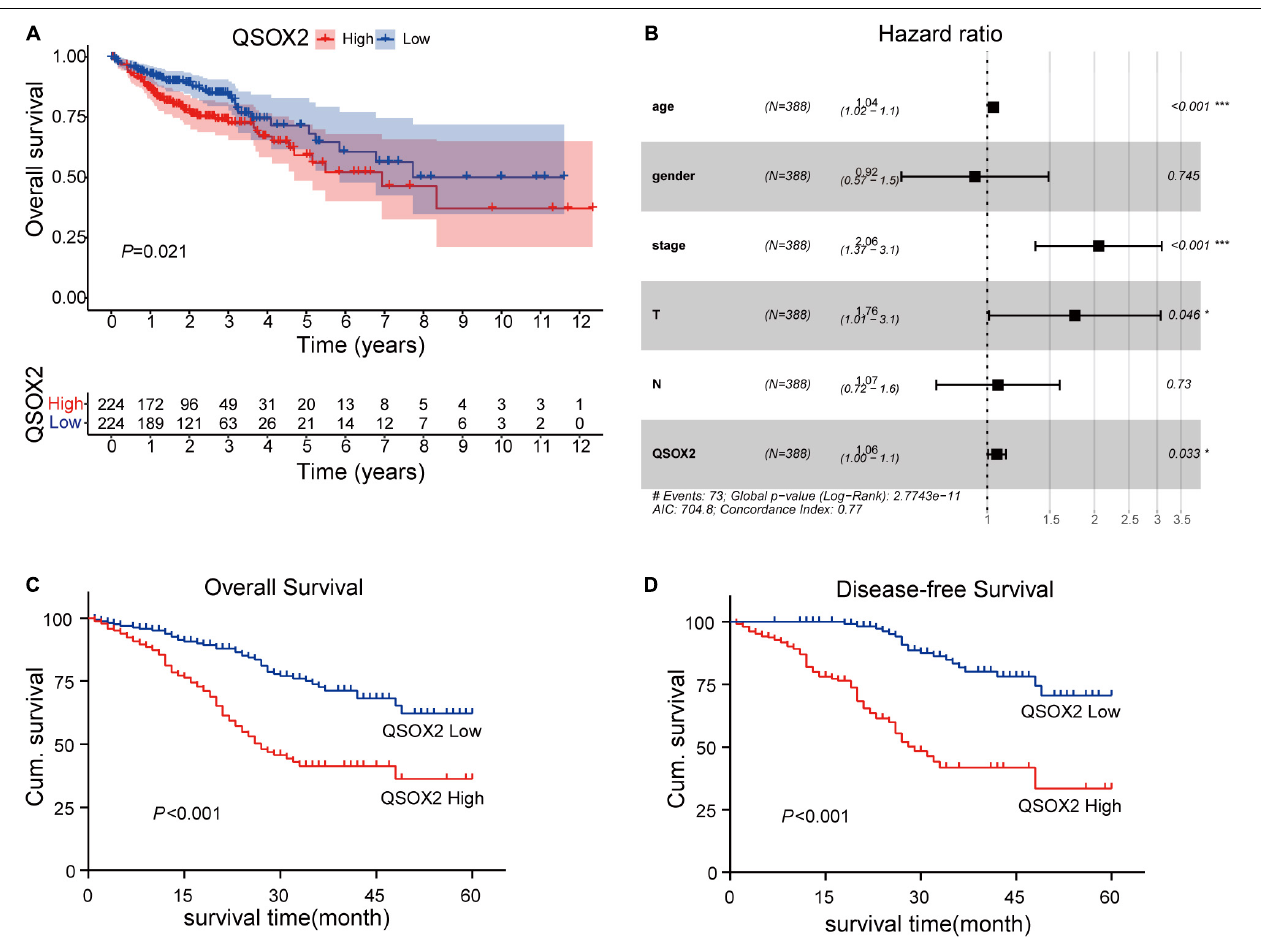
FIGURE 3 | Prognostic role of QSOX2 in CRC patients. (A) Kaplan–Meier survival curves show patients of CRC with high QSOX2 expression exhibited shorter overall survival (OS) ( n = 224, p = 0.021) based on TCGA database. (B) Forest plot shows that QSOX2 expression was an independent risk factor for CRC based on TCGA data (HR, 1.06; 95% CI, 1.00–1.13; p = 0.033). HR, hazard ratio; CI, confidence interval; * p < 0.05; *** p < 0.001. (C,D) Kaplan–Meier survival curves show that patients of CRC with high QSOX2 expression exhibited shorter OS ( n = 493, p < 0.001) and disease-free survival (DFS) based on clinical specimen